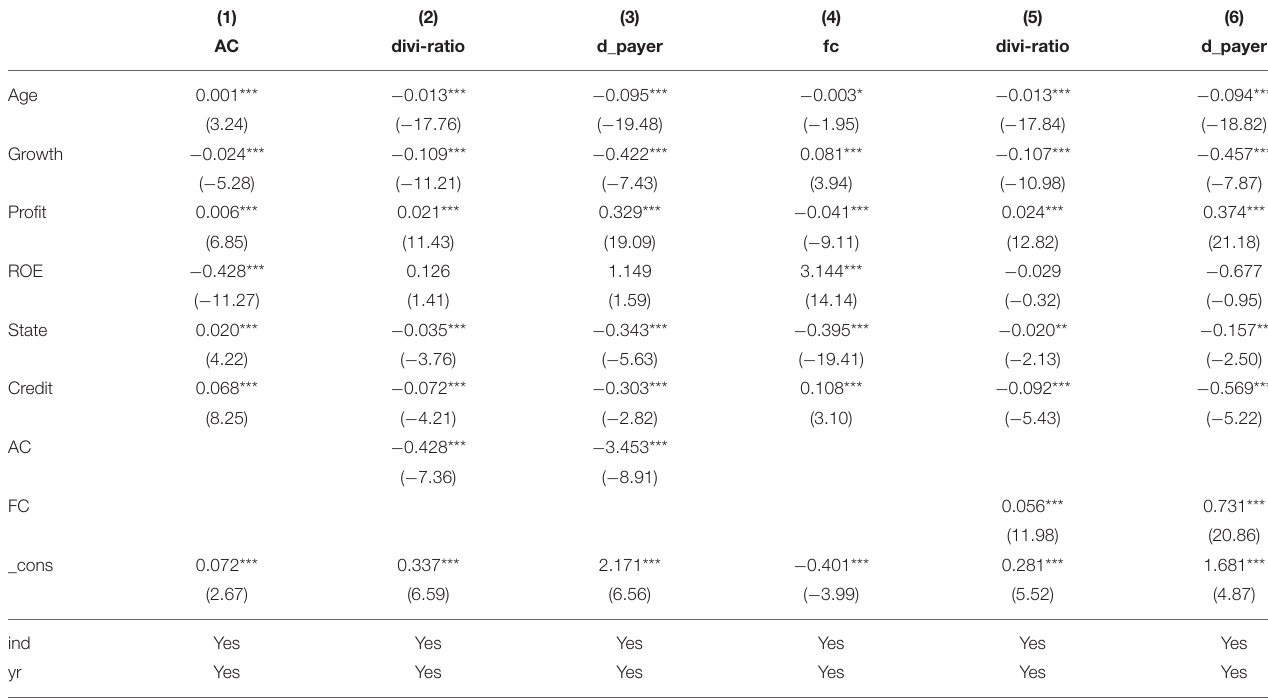
TABLE 7 | Supplier financing and cash dividend payment level mechanism